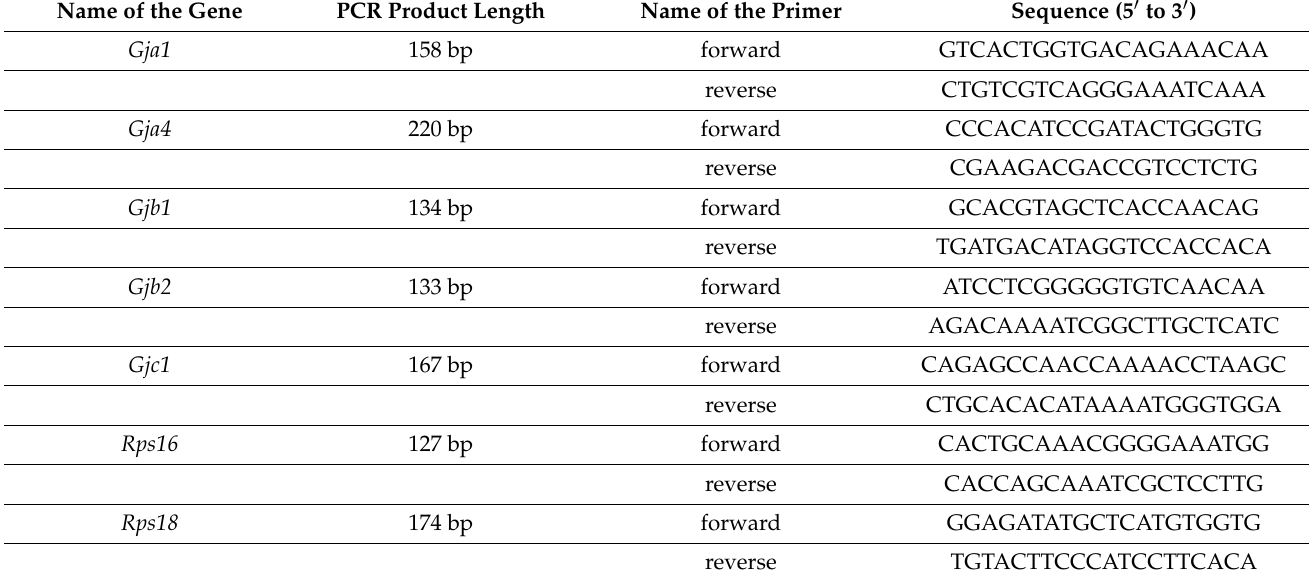
Table 1. List of primers used in the